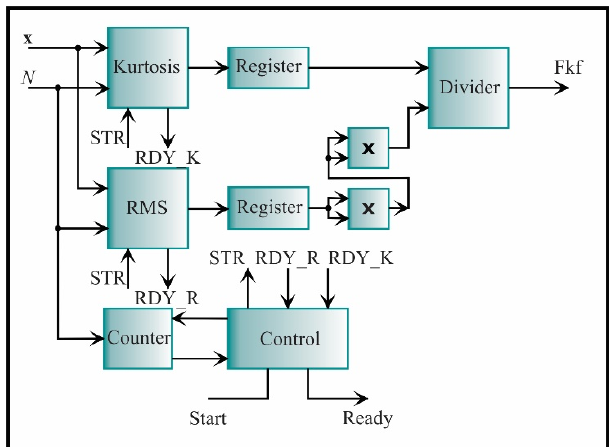
Figure 18. The architecture of the processing core for computing the kurtosis factor.